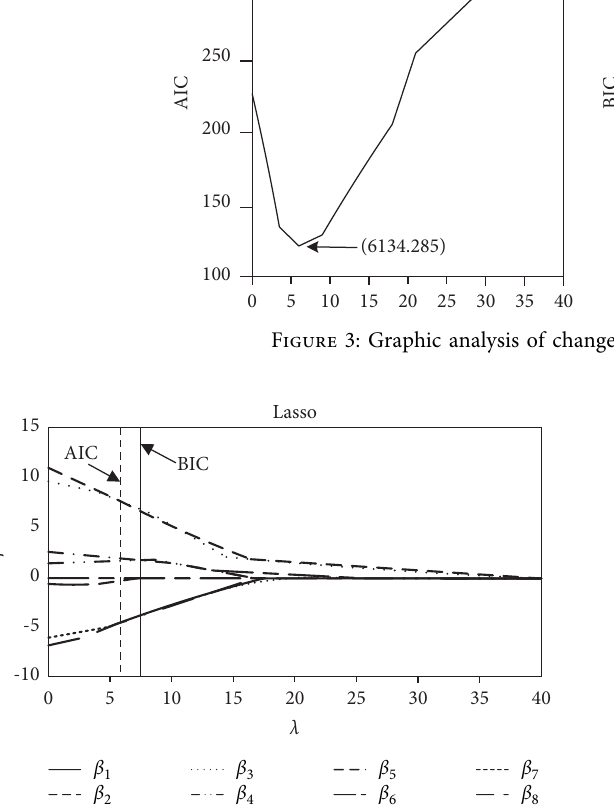
Figure 4: AIC and BIC truncation criteria corresponding to variable selection.